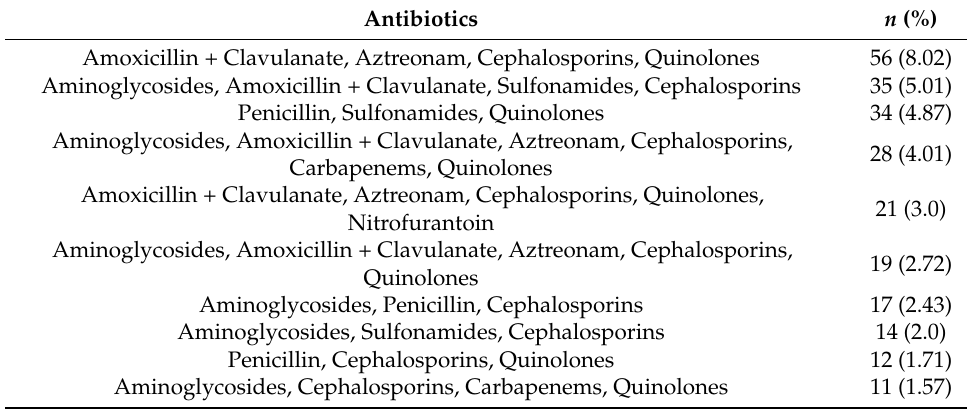
Table 4. Most common MDR